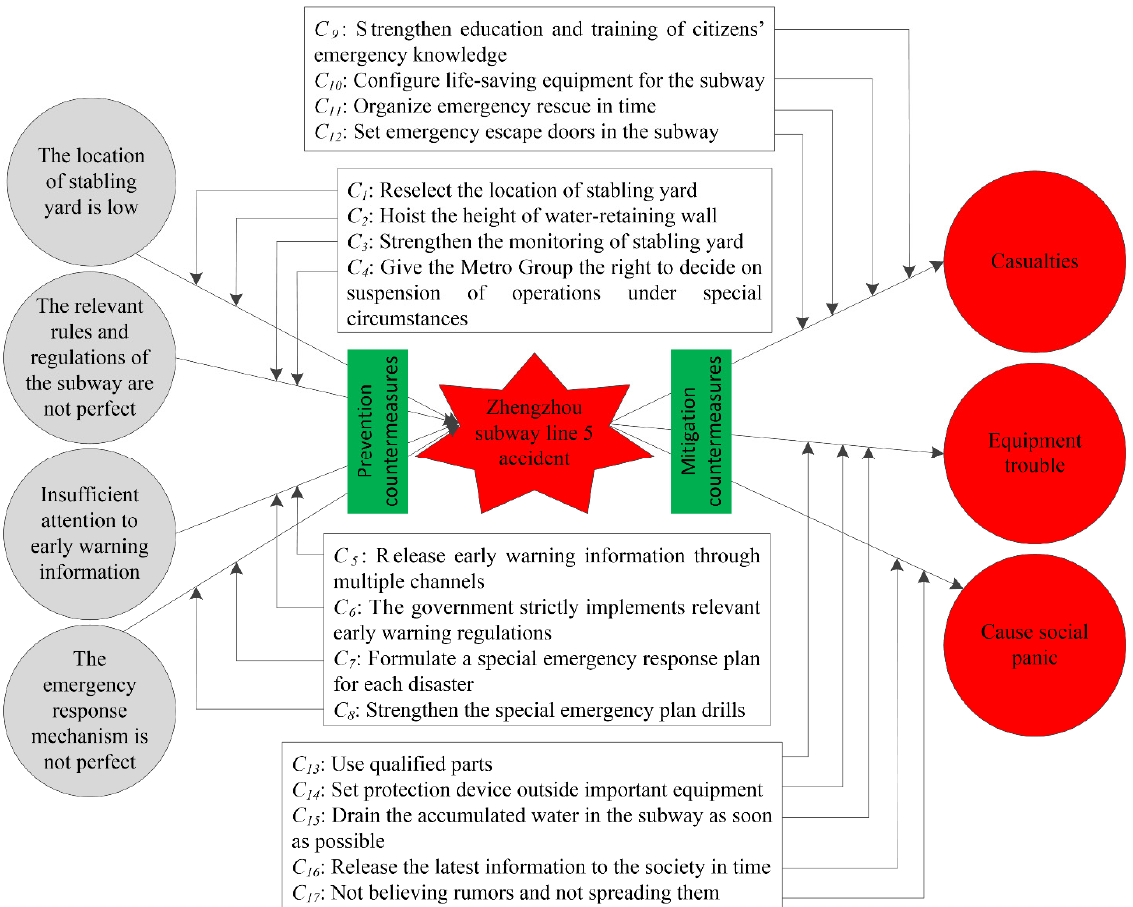
Figure 6. Bow-tie analysis of the Zhengzhou subway line-5 accident.